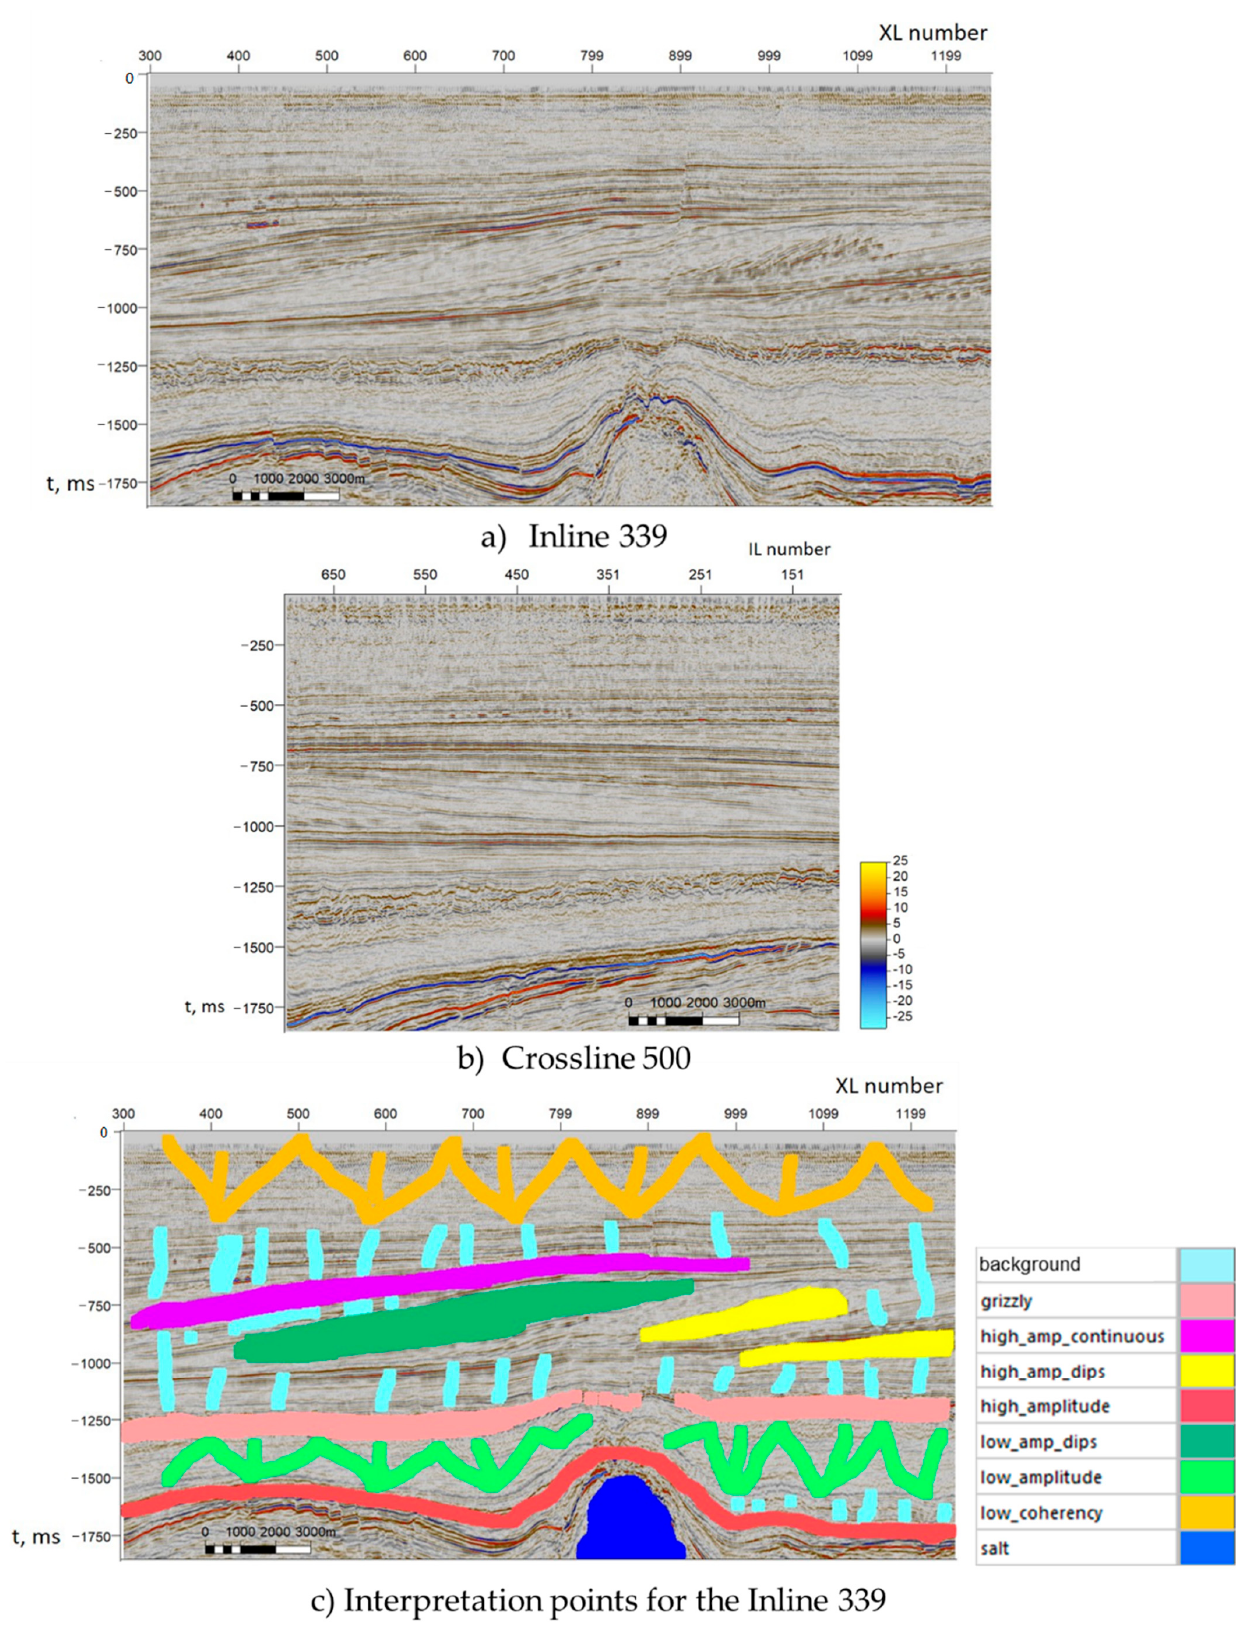
Figure 2. Inline 339 ( a ), crossline 500 ( b ), interpretation points for the IL339 that came as a part of the F3 dataset ( c ). In the legend, the different names represent different characteristics of seismic